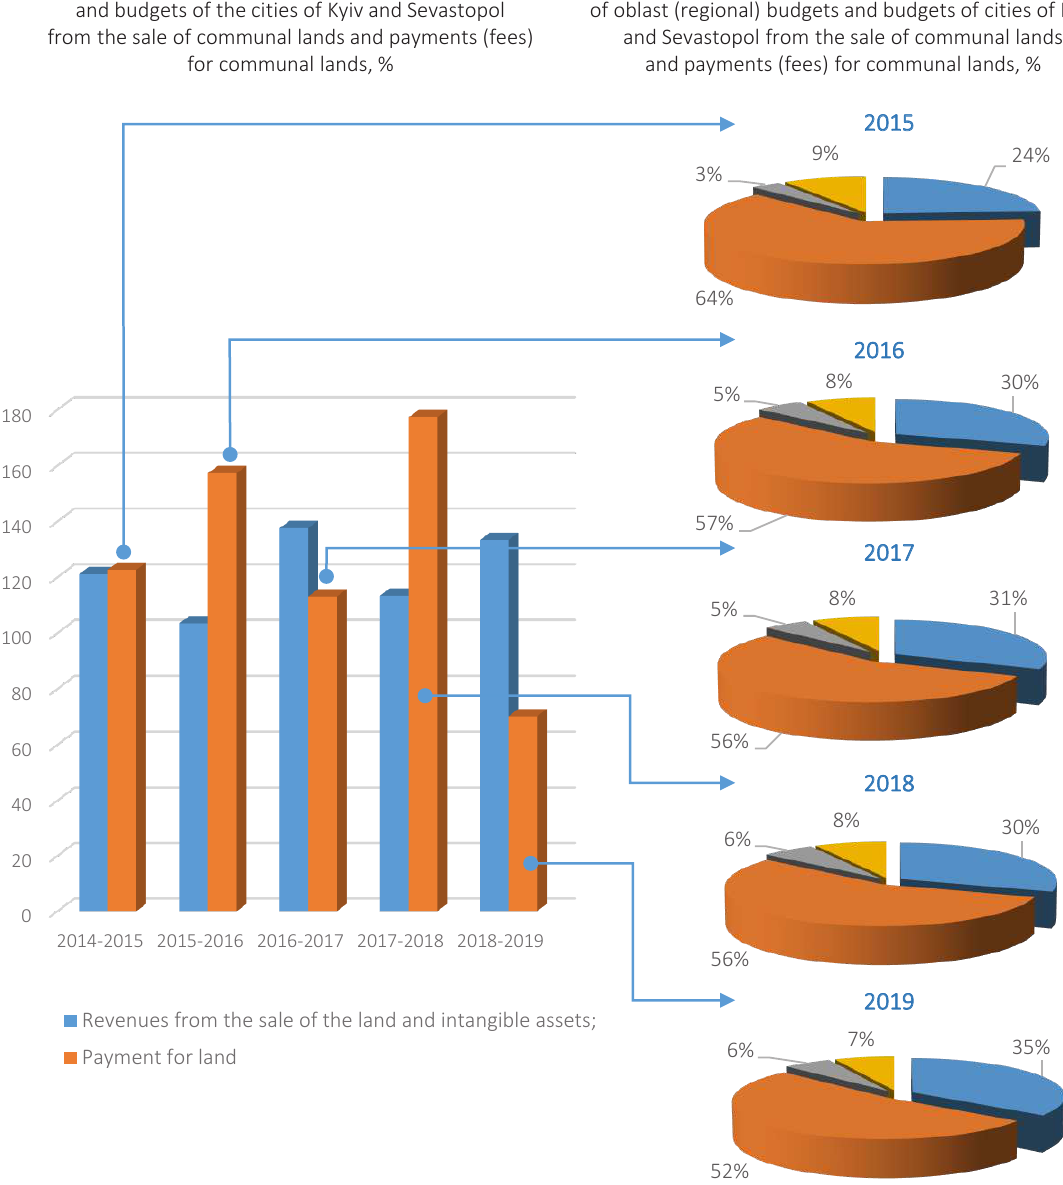
Figure 1. Growth rates and the structure of revenues in local budgets of